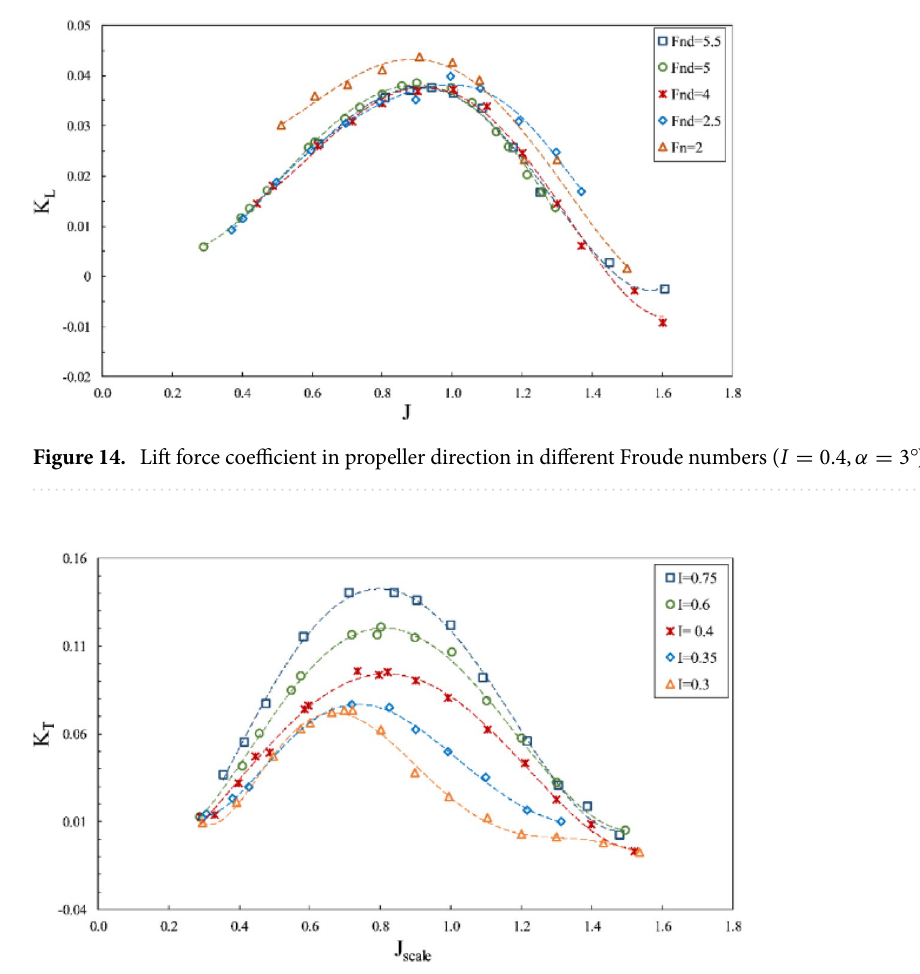
Figure 15. Effect of immersion ratio on the thrust coefficient in the propeller direction ( α = 6 ◦